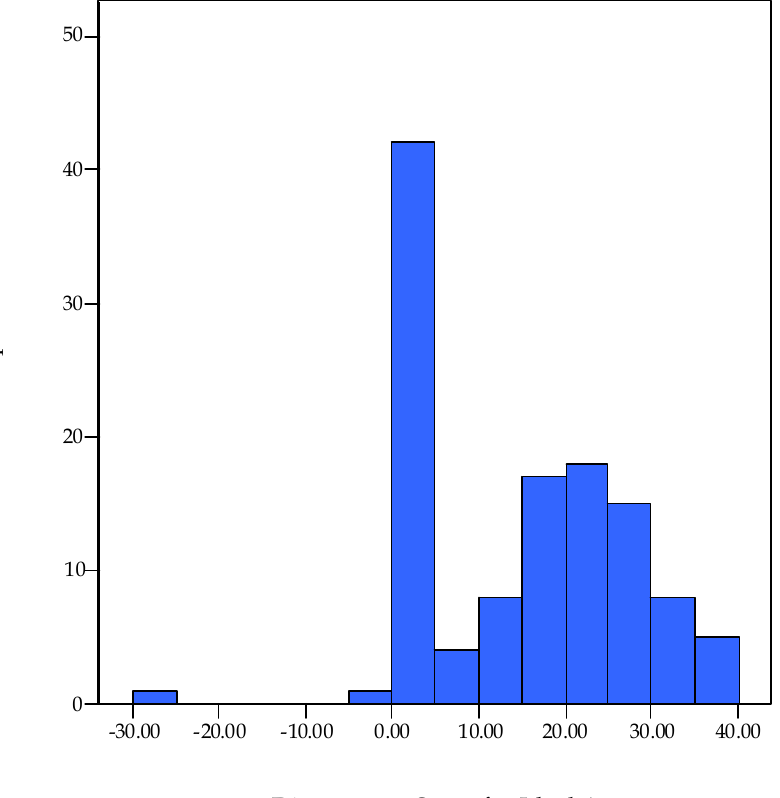
Figure 3 . Age Discrepancy Scores for Ideal Age: Actual Age minus ‘Would like to